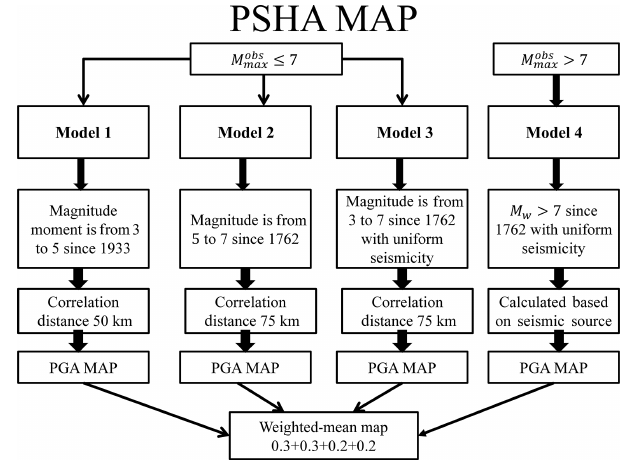
Figure 4. Four models used in the development of the PSHA map of Patna based on the zoneless